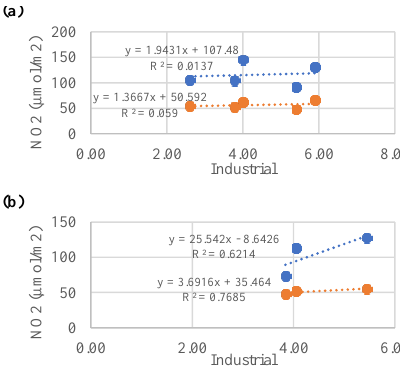
Figure 8. Influence of industrial landuse on NO 2